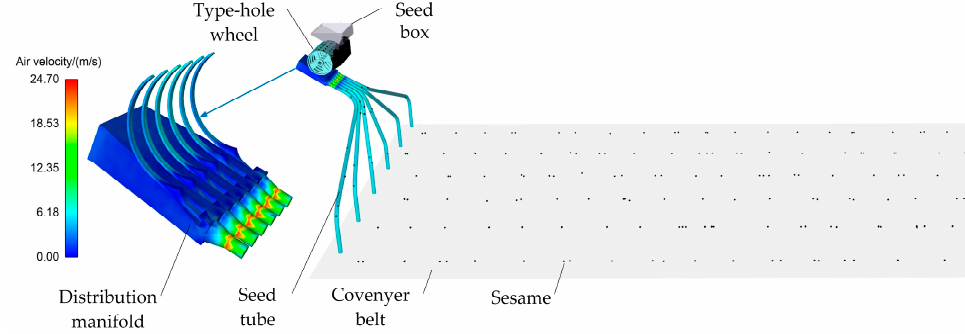
Figure 9. CFD–DEM coupling simulation